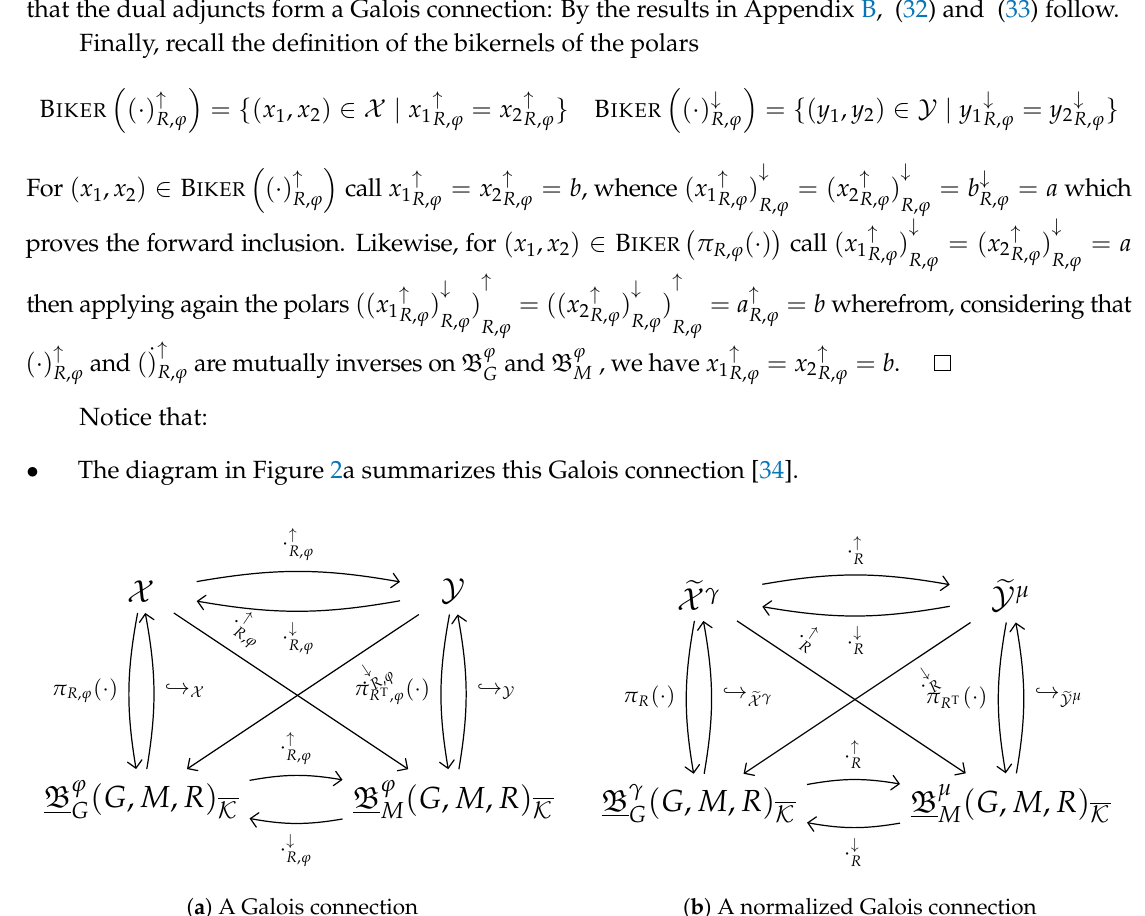
Figure 2. The Galois connection induced by a formal context between spaces ( · ↑